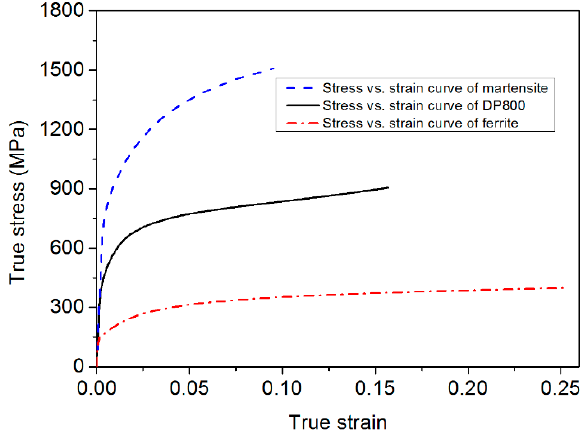
Figure 9. The stress vs. strain curves of martensite, ferrite, and DP800.